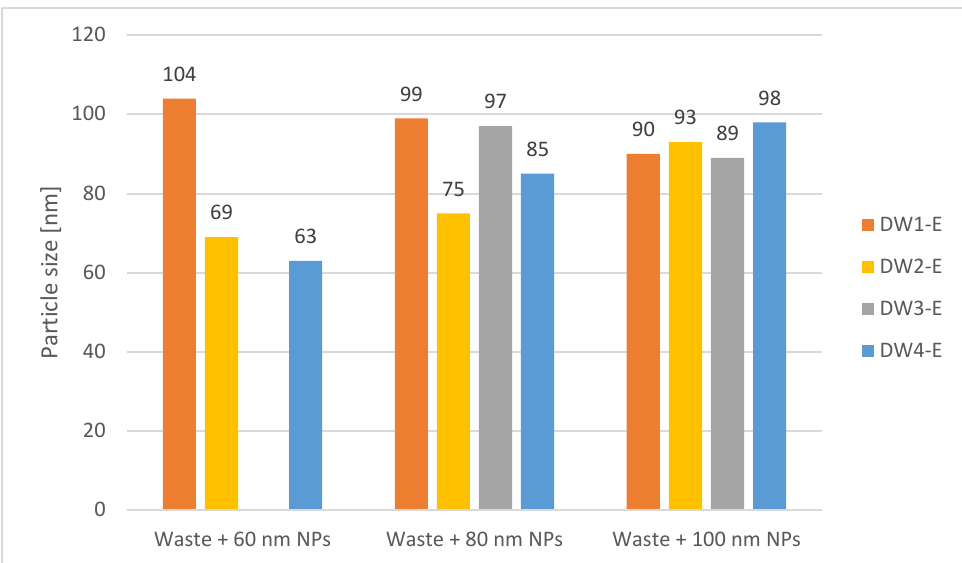
Figure 10. Results of AgNP separation by CPE from AgNP-enriched drilling waste filtrate samples DW(1–4)-E. Silver nanoparticles of three sizes, 60, 80, or 100 nm, were added to the samples. The graph shows the recovery results obtained after separation with CPE. Table 7. AgNP separation results for drilling waste extract samples DW(1 4)-E enriched with AgNPs after centrifugation at 2800 rpm for 12 min. Three different sizes of AgNPs were introduced into the drilling waste matrix, 60, 80, and 100 nm. The table shows mean particle diameter, particle diameter median, and most common particle size. Size of AgNPs Mean Particle Matrix Introduced into Separation Method the Matrix (nm)